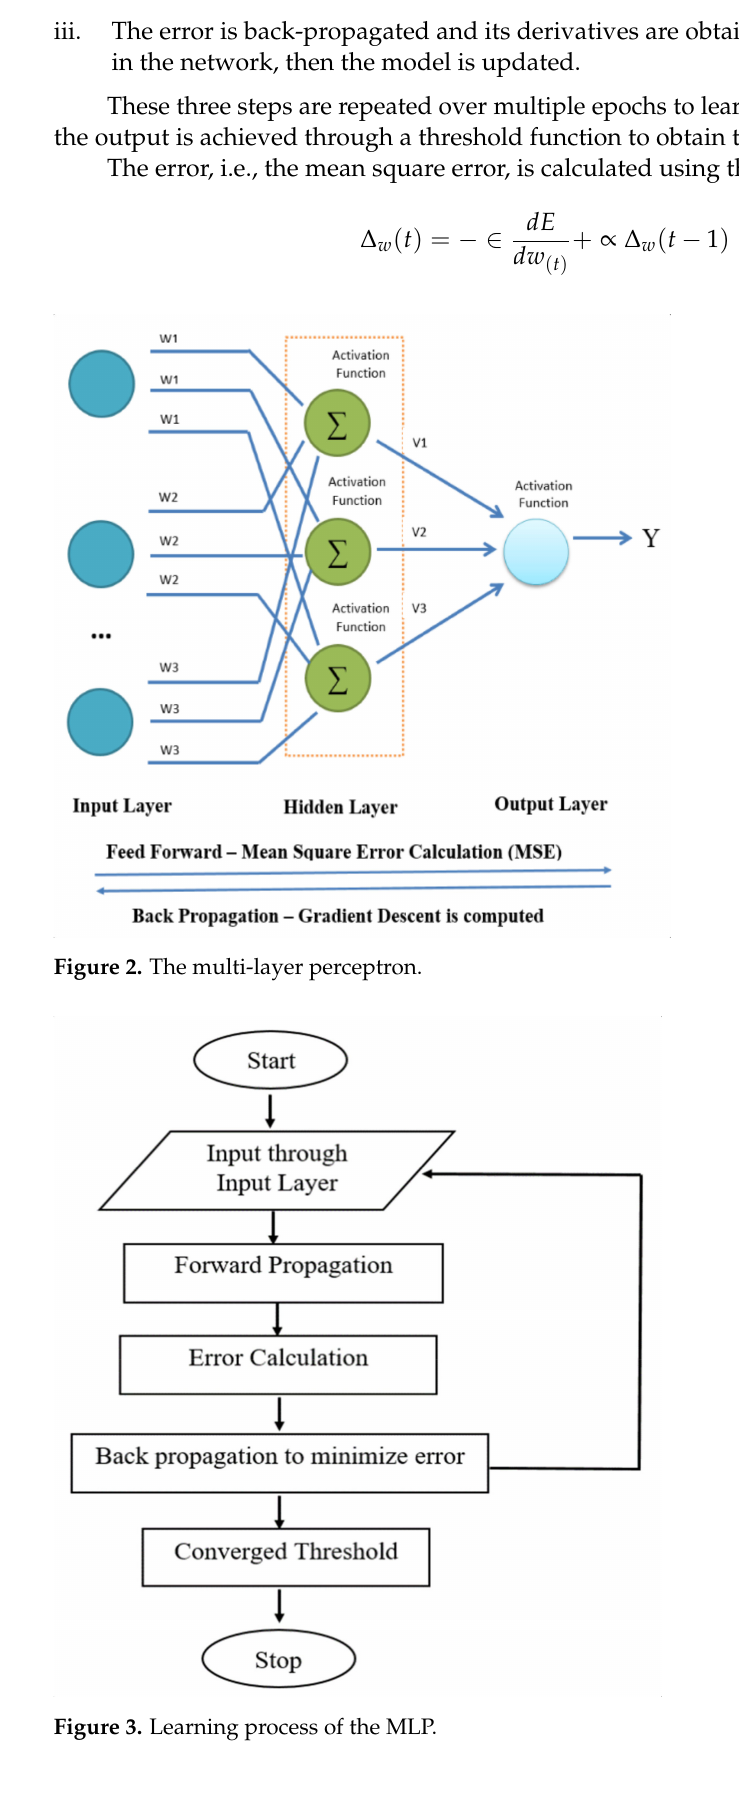
Figure 3. Learning process of the